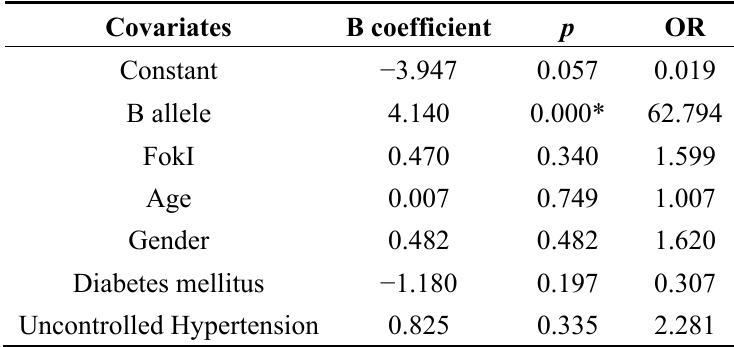
Table 4. Results of logistic regression model for left ventricular hypertrophy (LVH) in CKD 3b